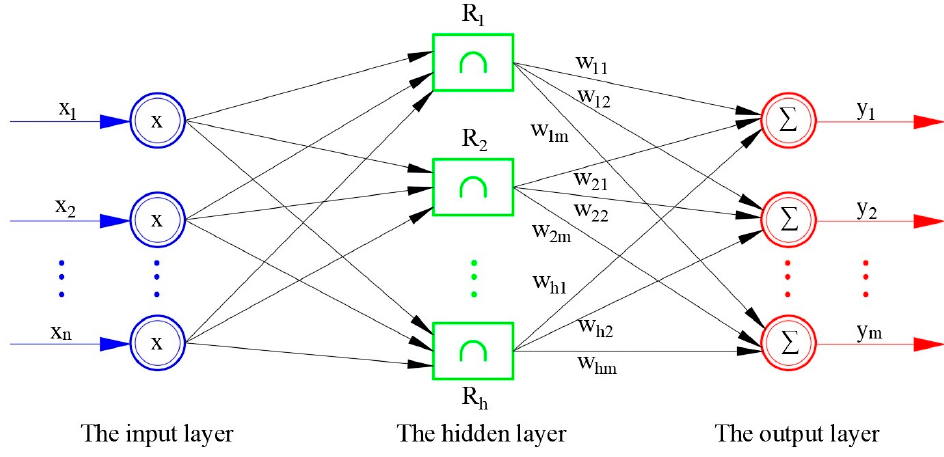
Figure 2. The topology structure of the RBFNN.